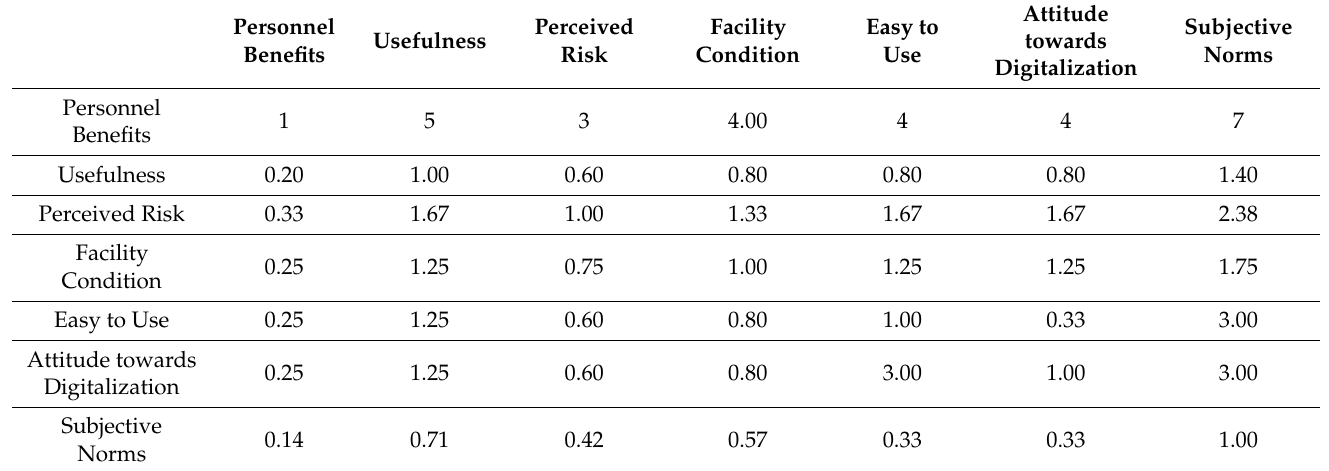
Table 3. Pairwise comparison for each constraint using the seven-point Likert